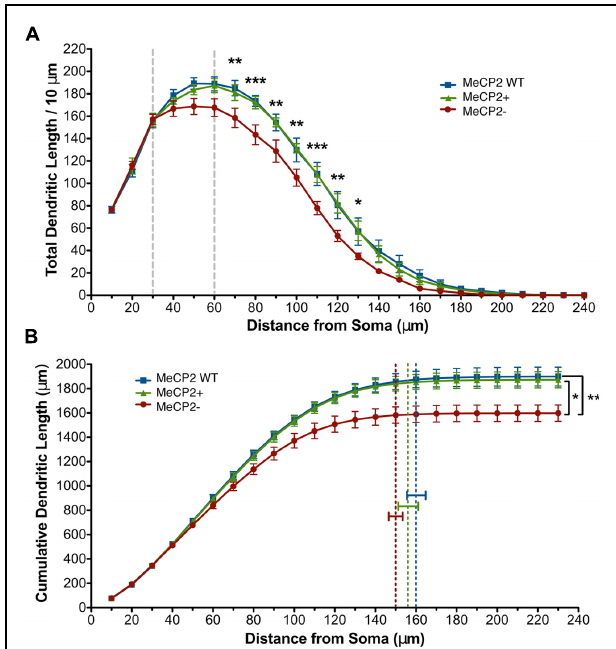
FIGURE 4 | Total dendritic length of MeCP2- neurons is reduced. (A) MeCP − neurons have decreased dendritic length at distances of 70–130 µ m from the soma compared to both MeCP2 WT and MeCP2 + neurons. The region between the dashed lines indicates where the slopes of MeCP2 − and MeCP2 + cells deviate. (B) MeCP2 − neuron total basal dendritic length is 15% less (275 µ m) compared to both MeCP2 WT and MeCP2 + neurons. Dashed lines indicate the average maximum radial distance reached for each genotype. No significant difference was found between the genotypes in this measure. ∗ p < 0.05, ∗∗ p < 0.01, and ∗∗∗ p < 0.001. For Figures 4–6 , 82 MeCP2 WT neurons, 98 MeCP2 + and